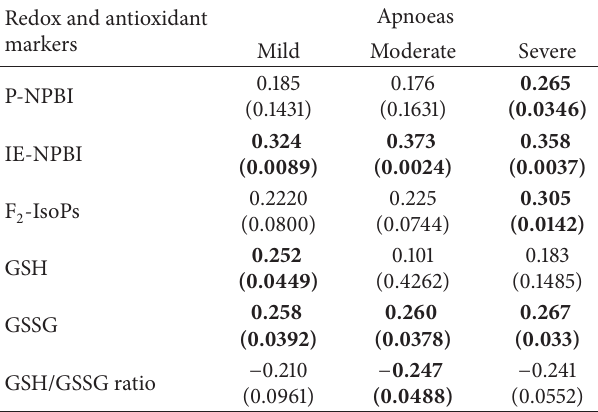
Table 5: Correlation matrix between redox/antioxidant status and severity of recorded apnoeas, either during wakefulness or sleep, in patients with typical Rett syndrome ( 𝑁 = 228